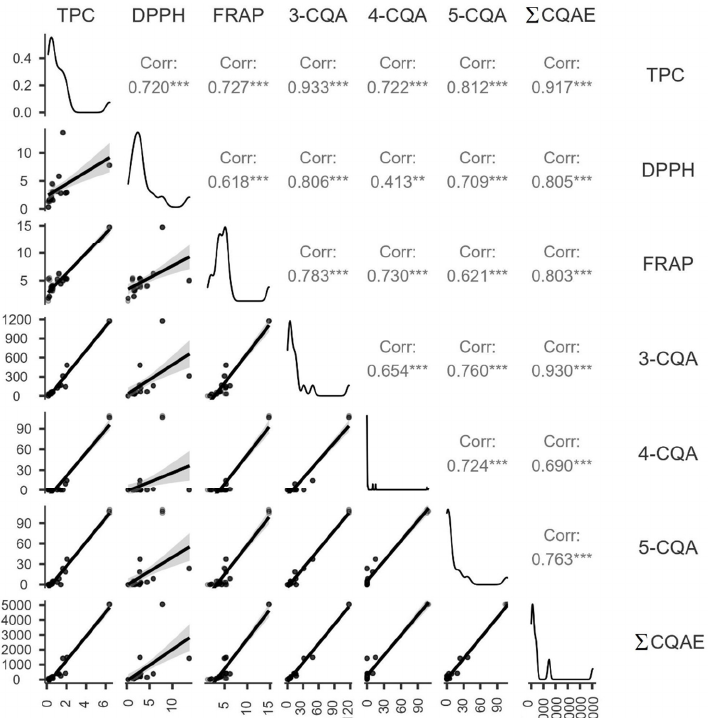
Figure 8. Spearman’s correlation coefficient between total polyphenol content (TPC), antioxidant activity (DPPH and FRAP), and individual chlorogenic acids in sweet potatoes (*** represents very strong correlation, ** represents strong